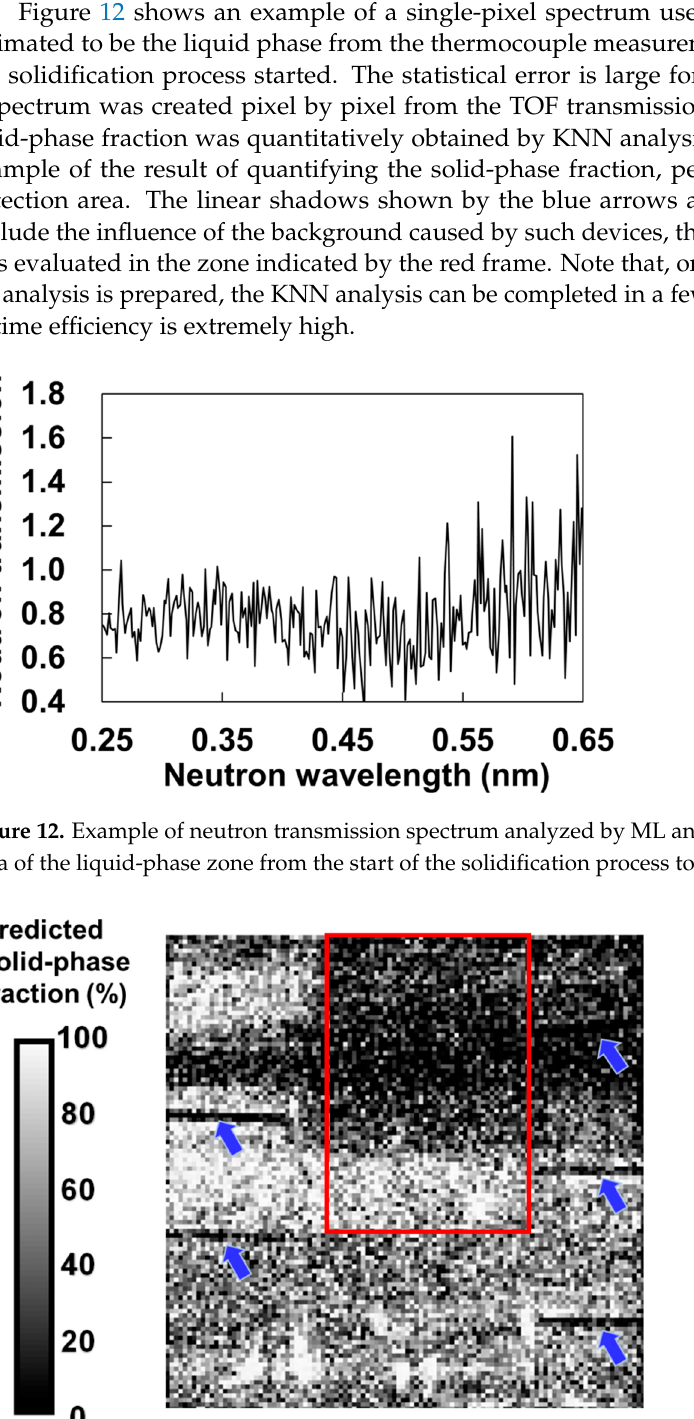
Figure 11. Examples of 100 mm × 100 mm images of the first through fifth principal components (PC) obtained by the PCA of the neutron transmission spectrum at each pixel (after solidification).